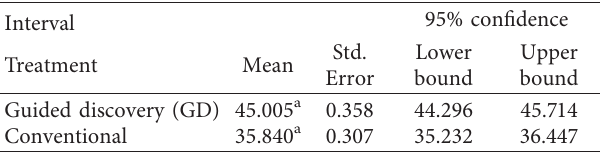
Table 3: Postattitude rating by treatment estimated marginal